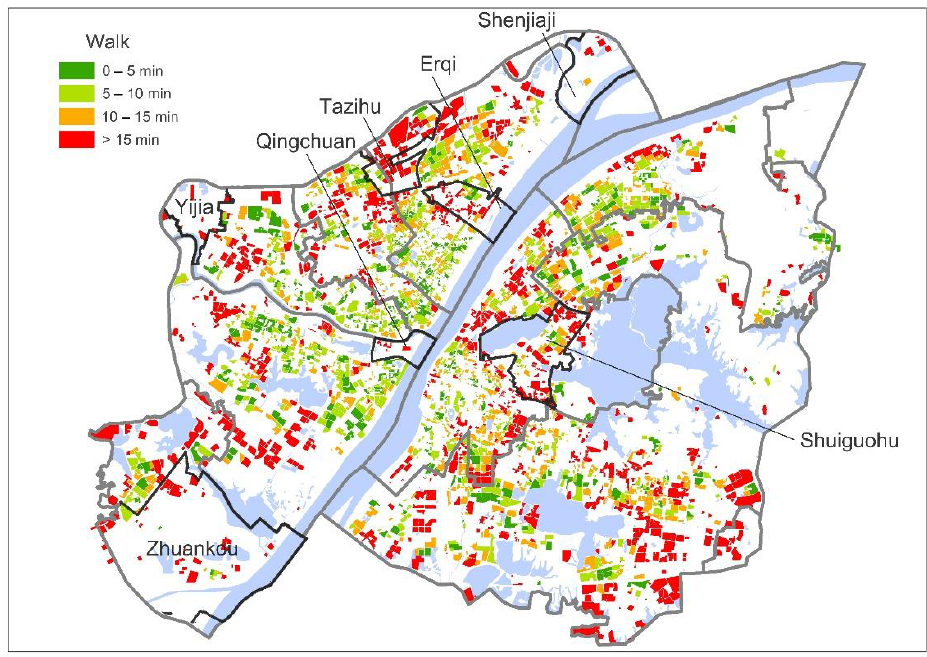
Figure 5. The walking time thresholds from communities to the community healthcare centers.